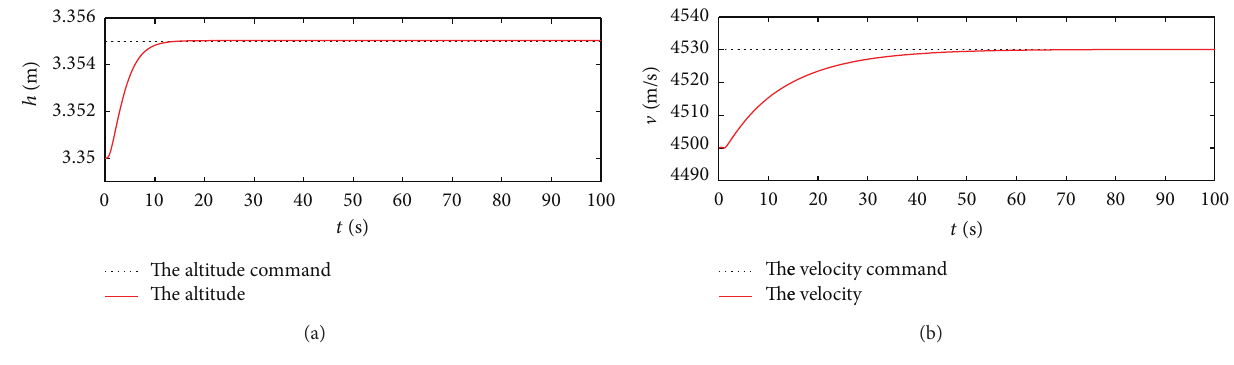
Figure 7: Response curves to the altitude and velocity